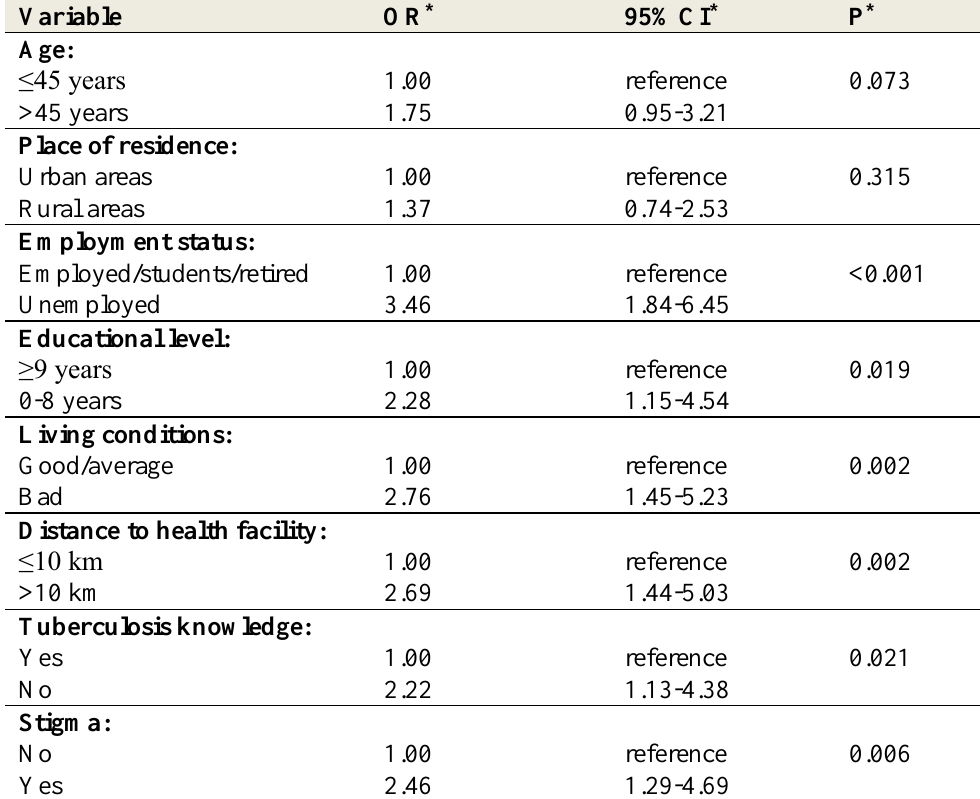
Table 2. Sex-differences in socioeconomic characteristics, knowledge and attitudes about tuberculosis, and access to health care among tuberculosis patients in Albania; crude/unadjusted odds ratios from binary logistic